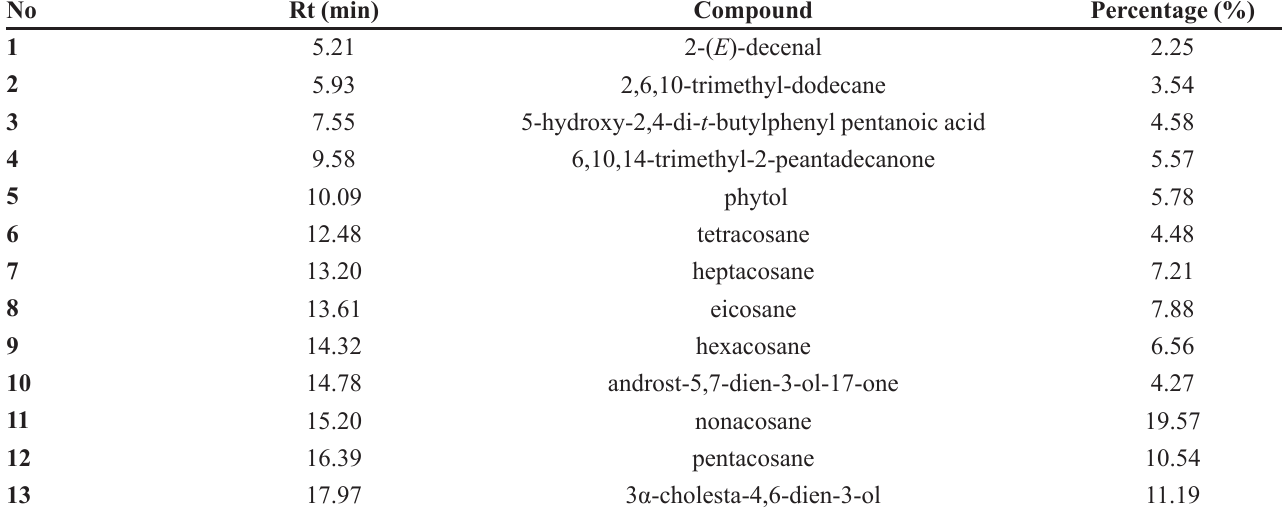
TABLE I - Main chemical components (%) of